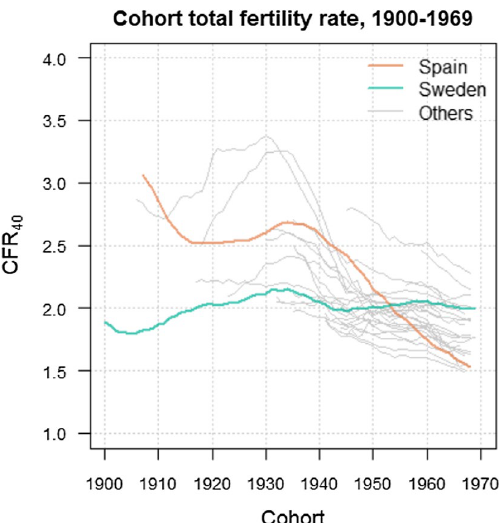
Fig. 1 Cohort fertility by age 40 of women in Spain, Sweden and selected countries. Source: Calculated by authors based on Human Fertility Database (2021). CFR for Spanish women end with the 1978 cohort, respectively, while CFR for Swedish women end with the 1979